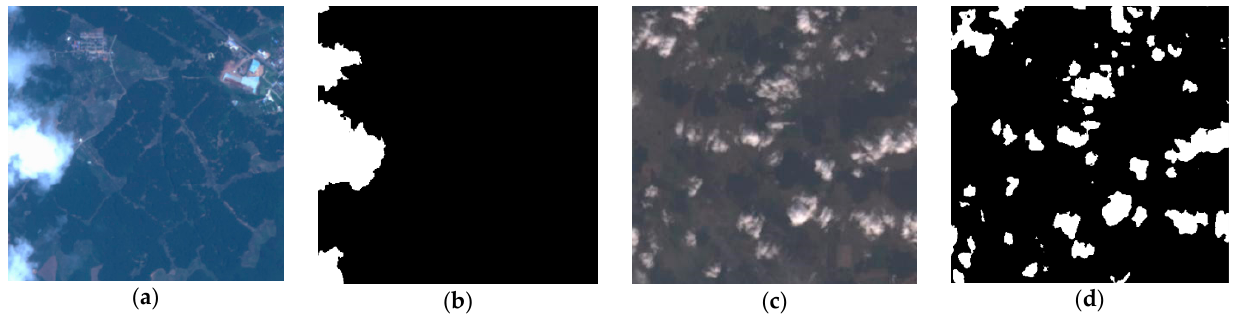
Figure 1. Training images and label images. ( a ) GF-2 true color images. ( b ) GF-2 ground truth images. ( c ) Landsat8 true color images. ( d ) Landsat8 ground truth images.